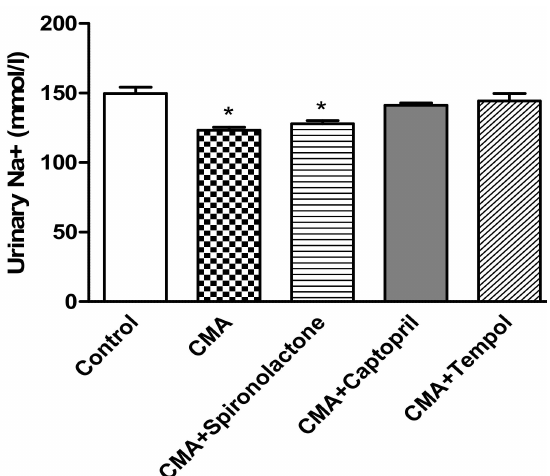
Figure 5. Urinary sodium analysis. Each bar represents values expressed as mean ± SEM. The change in urine sodium levels were considered significant (*) when p < 0.05 between groups. The data were analyzed using one-way ANOVA followed by Tukey’s multiple comparison test among all five groups.